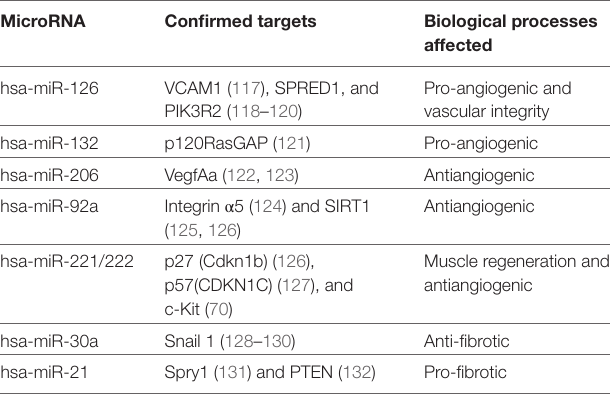
TAbLe 2 | Overview of the confirmed targets for micoRNAs regulated by